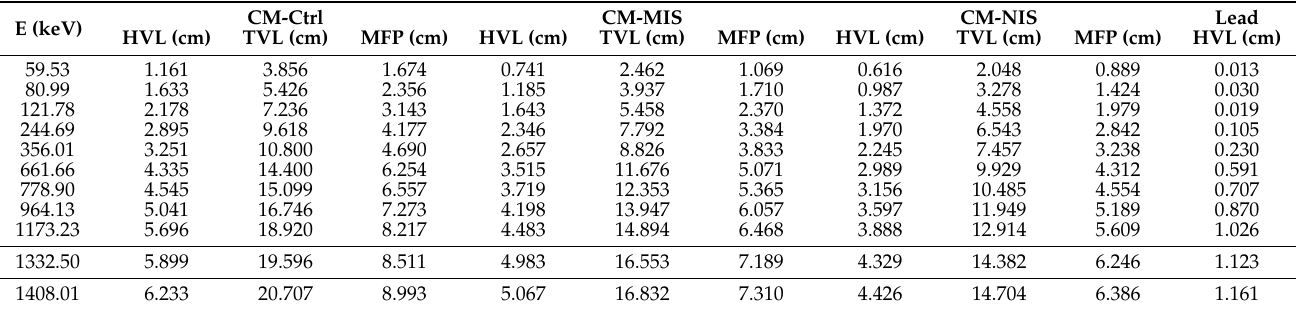
Table 7. The values of HVL, TVL, and MFP of the tested mortars in addition to lead.